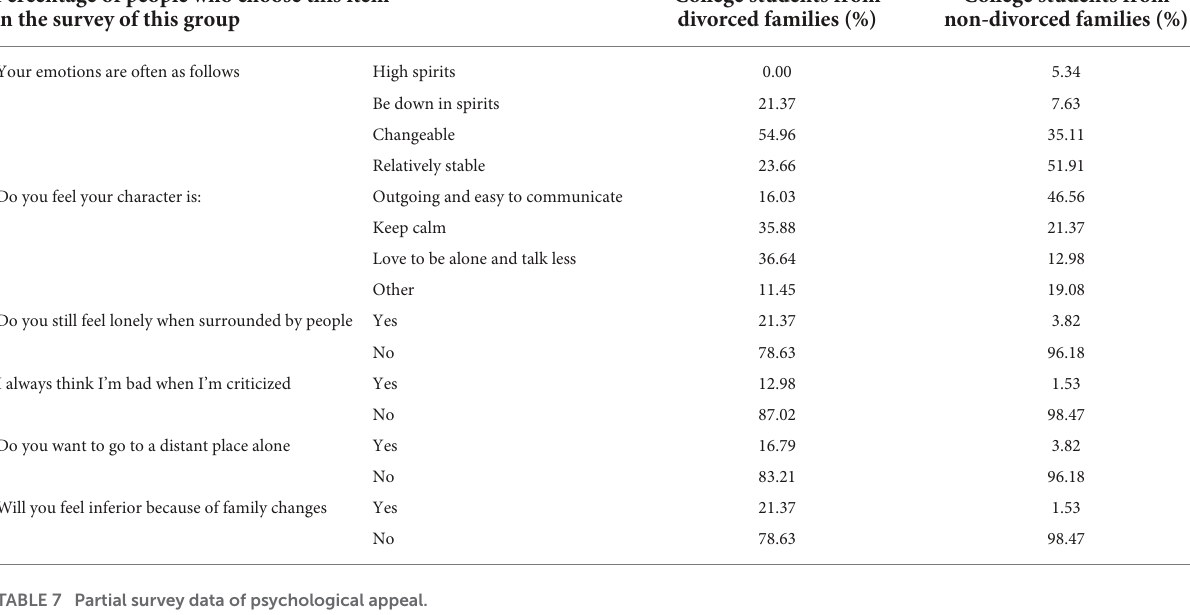
TABLE 7 Partial survey data of psychological